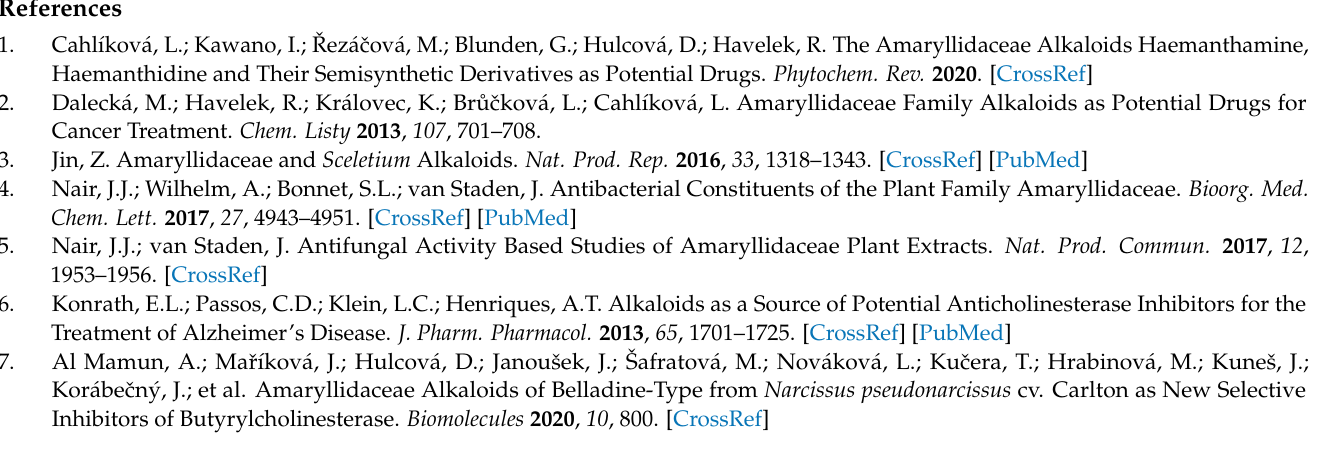
Supplementary Materials: Figure S1. ESI-HRMS spectrum of 9- O -demethyllycorenine ( 1 ); Figure S2. ECD data of 9- O -demethyllycorenine ( 1 ), and lycorenine; Figure S3. 1 H-NMR spectrum of 9- O - demethyllycorenine ( 1 ) in CDCl 3 ; Figure S4. 13 C-NMR spectrum of 9- O -demethyllycorenine ( 1 ) in CDCl 3 ; Figure S5. COSY spectrum of 9- O -demethyllycorenine ( 1 ); Figure S6. HSQC spectrum of 9- O - demethyllycorenine ( 1 ); Figure S7. HMBC spectrum of 9- O -demethyllycorenine ( 1 ); Figure S8. H2BC spectrum of 9- O -demethyllycorenine ( 1 ); Figure S9. NOESY spectrum of 9- O -demethyllycorenine ( 1 ); Figure S10. ESI-HRMS spectrum of narciabduliine ( 2 ); Figure S11. 1 H-NMR spectrum of narciabduliine ( 2 ) in CDCl 3; Figure S12. 13 C-NMR spectrum of narciabduliine ( 2 ) in CDCl 3 ; Figure S13. COSY spectrum of narciabduliine ( 2 ); Figure S14. HSQC spectrum (aromatic region) of narciabduliine ( 2 ); Figure S15. HSQC spectrum (aliphatic region) of narciabduliine ( 2 ); Figure S16. HMBC spectrum of narciabduliine ( 2 ); Figure S17. H2BC spectrum of narciabduliine ( 2 ); Figure S18. NOESY spectrum of narciabduliine ( 2 ); Figure S19. Stacked plot of dynamic NMR analysis of narciabduliine ( 2 ) at different temperatures (CDCl 3